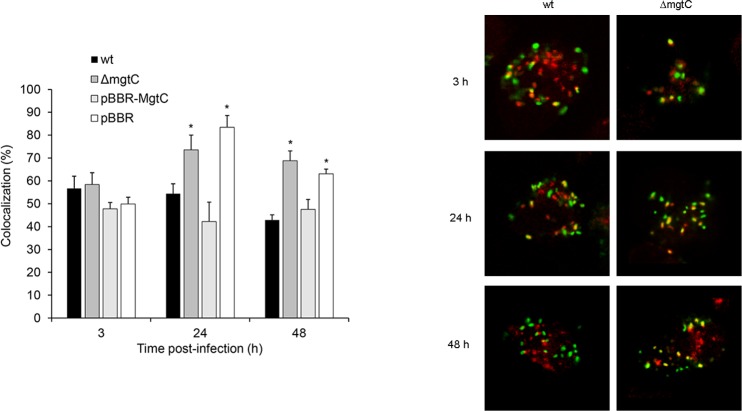
Time course of B. pertussis colocalization with the acidotropic dye LysoTracker.Wild type B. pertussis (wt), B. pertussis mgtC deficient mutant (ΔmgtC), B. pertussis mgtC deficient mutant carrying the pBBR1MCS vector (pBBR), and B. pertussis mgtC deficient mutant carrying a pBBR1MCS derivative that encodes mgtC (pBBR-mgtC) were incubated with THP-1 cells (MOI: 100) for 2 h at 37°C. After being washed, the macrophages were incubated with polymyxin B (100 μg/mL) prior incubation with LysoTracker (3 h), or further incubated with RPMI-FBS-polymyxin B (5 μg/mL) for other 24 and 48 h before treatment with the acidotropic dye LysoTracker (red). Intracellular bacteria were green fluorescently labelled prior to confocal microscopy analysis. Colocalization of bacteria and LysoTracker is refected by yellow areas. The bars indicate the percentage of LysoTracker-positive phagosomes. The means ± SD of triplicates of one representative experiment out of two performed are given. The percentage of ΔmgtC and pBBR colocalizing with LysoTracker at 24 h and 48 h post-infection was significantly different from the number of wt and pBBR-mgtC bacteria colocalizing with LysoTracker at the respective time points. Statistical significance analysis was performed using one-way ANOVA (*P<0.05). Confocal microscopy images of a representative experiment are shown.